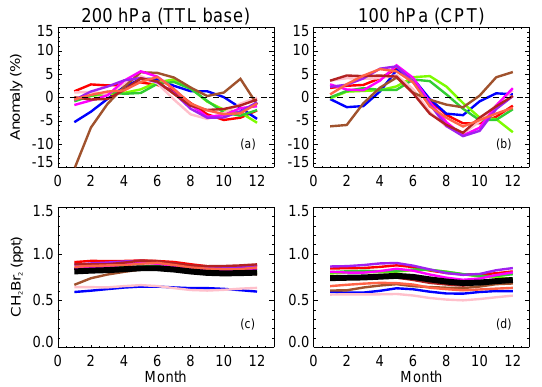
Figure 13. As Fig. 12 but for CH 2 Br 2 .